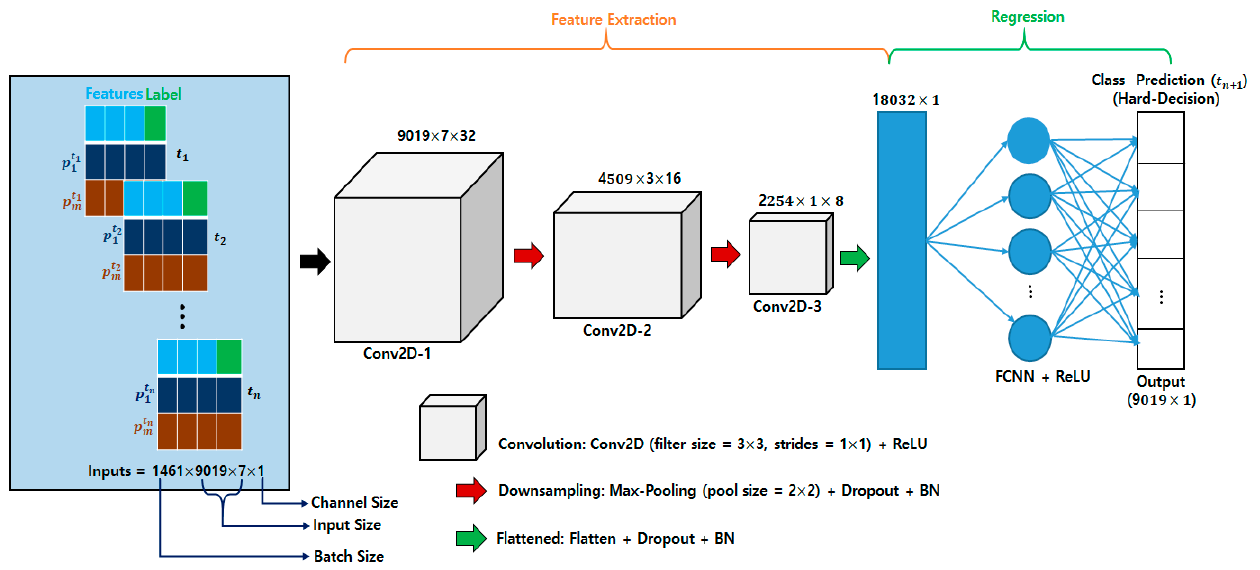
Figure 10. DLCC model to classify MovieLens dataset on the basis of popularity.